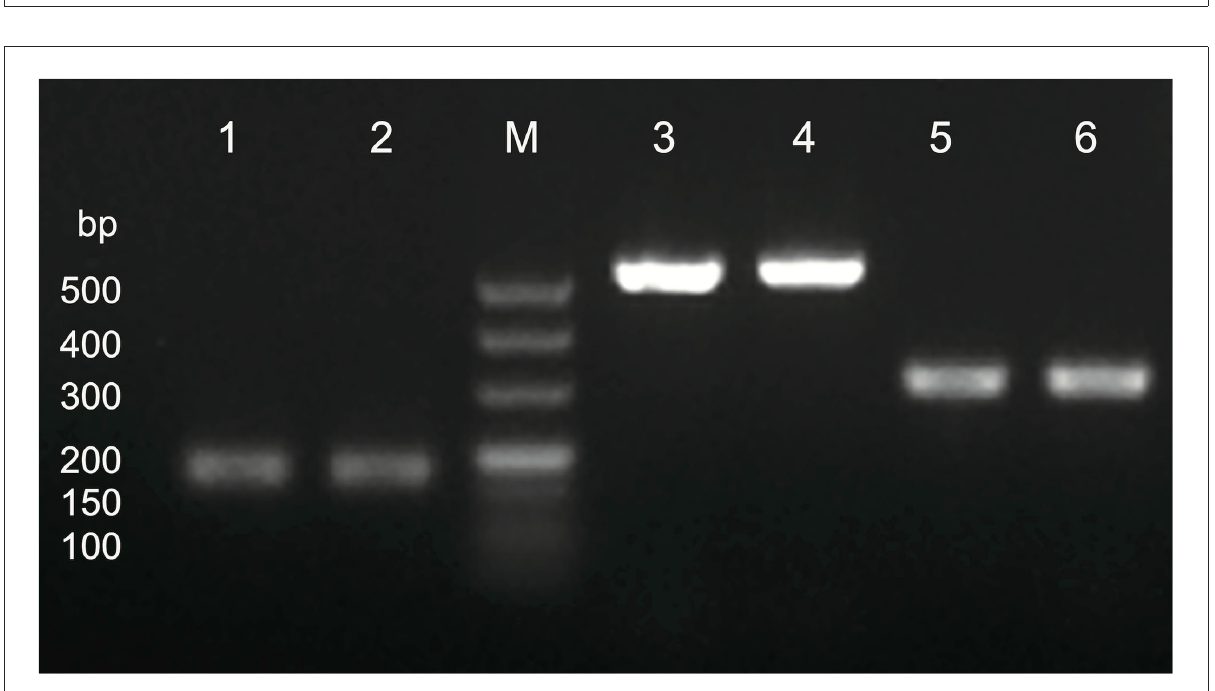
FIGURE3 Virulence genes of H. pylori ZJC03. Lane M, maker; lane 1 and 2, cagA ; lane 3 and 4, vacA s1/s2 ; lane 5 and 6, vacA m1/m2